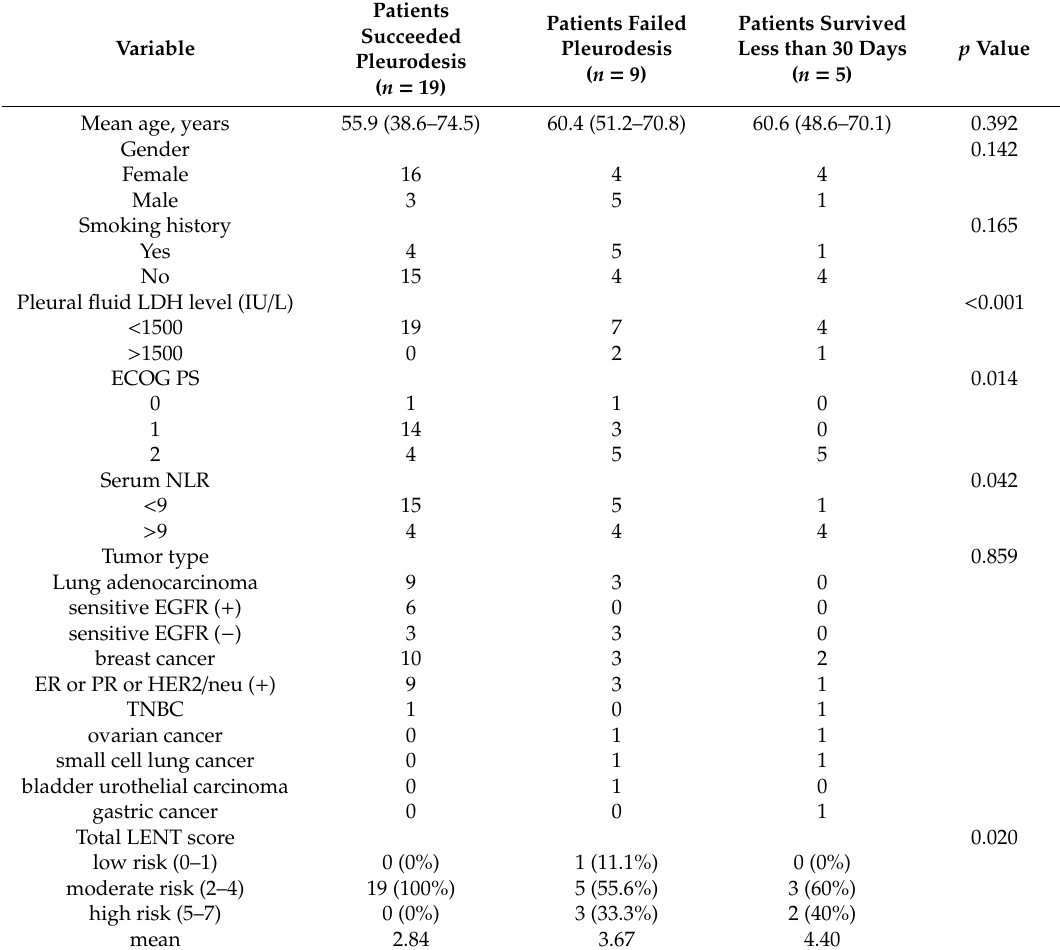
Table 1. Characteristics of the patients underwent pleurodesis stratified by the